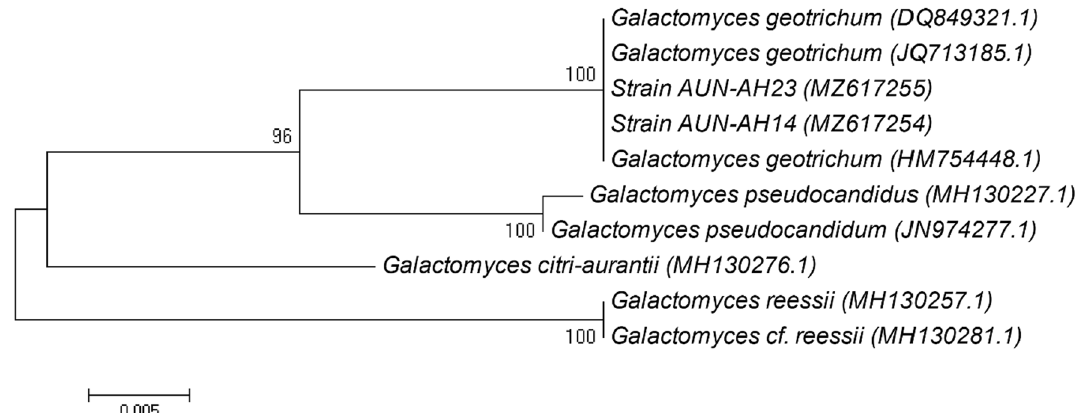
Fig.1 Phylogenetic relationships AUN‑AH14 and AUN‑AH23and 26S rRNA gene sequences from other published Galactomyces spp. by